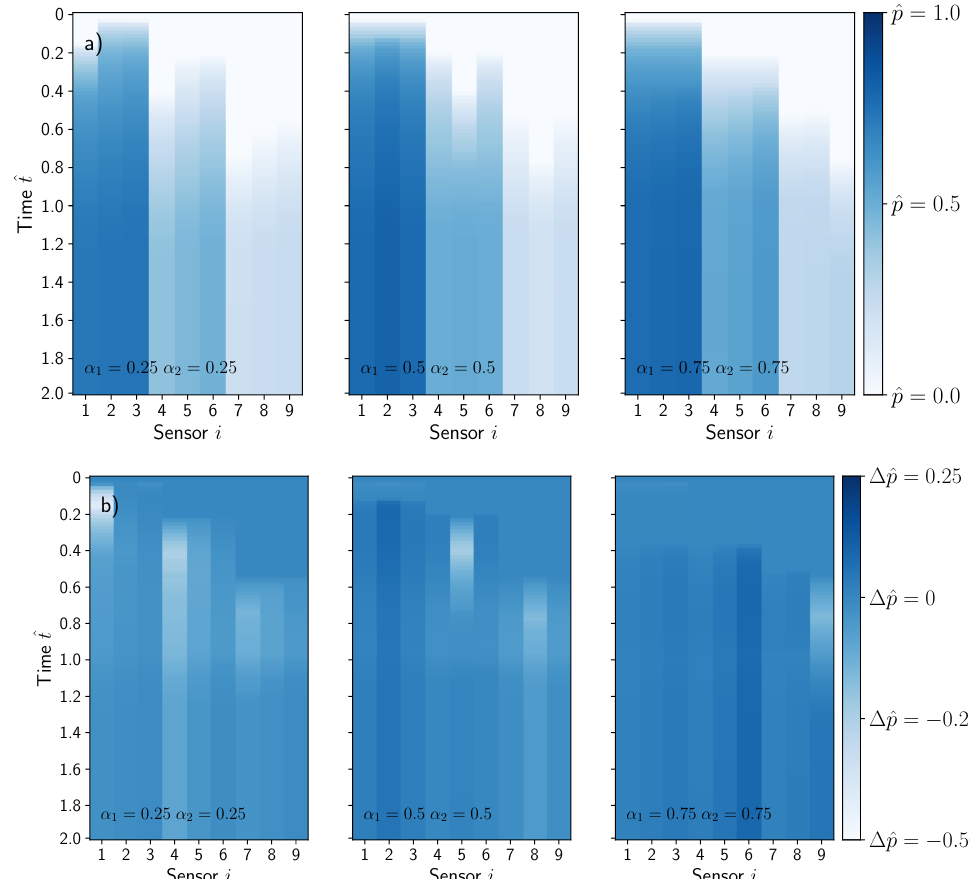
Figure 5. ( a ) Sensor footprints corresponding to the plot cases presented in Figure 4. The vertical and horizontal axis of the images corresponded with the non-dimensional time ˆ t and sensor position i = 1,9. The color intensity reflects the sensor non-dimensional pressure ˆ p , ( b ) Pressure perturbation ∆ ˆ p ( ˆ t ) evolution footprint. For visualization purposes, the non-dimensional time was arbitrarily extended to ˆ t =